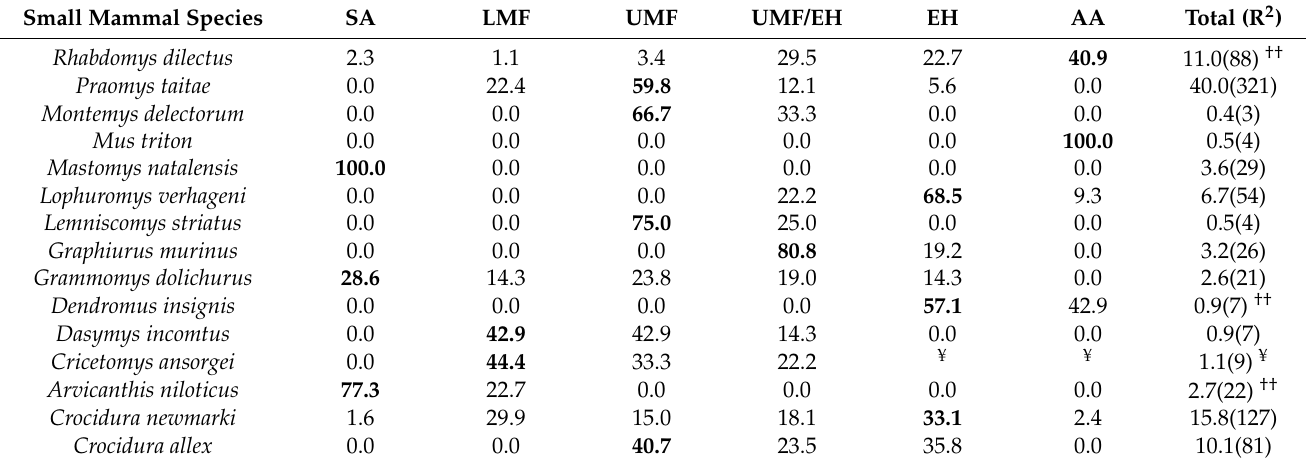
Table 3. Percentage of relative abundance of small mammal species across sites on Mount Meru. A linear regression model (R 2 ) was used to check the relationship between the percentage of relative abundance of each species and